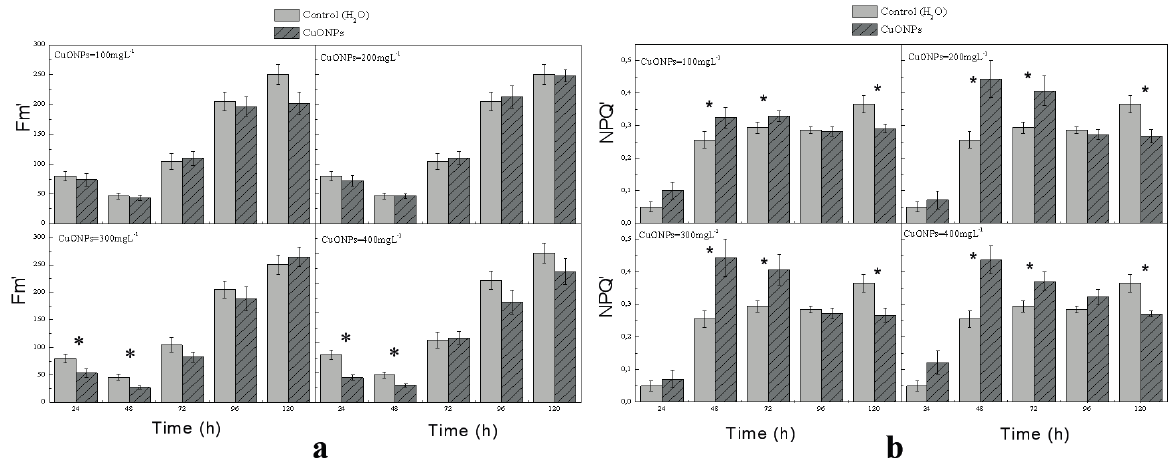
Figure 4. (a): Means of Fm’ of 12 seeds of Sesbania virgata , as a function of time, after soaking for 12 h in an aqueous solution of 0, 100, 200, 300 and 400 mgL -1 CuONPs (< 50 nm). * Signifi cant difference (t-test, p < 0.05, n = 12). (b): NPQ’ means of 12 seeds of Sesbania virgata as a function of time after being exposed to 0, 100, 200, 300 and 400 mgL -1 CuONPs (< 50 nm). * Signifi cant difference (t-test, p < 0.05, n = 12).